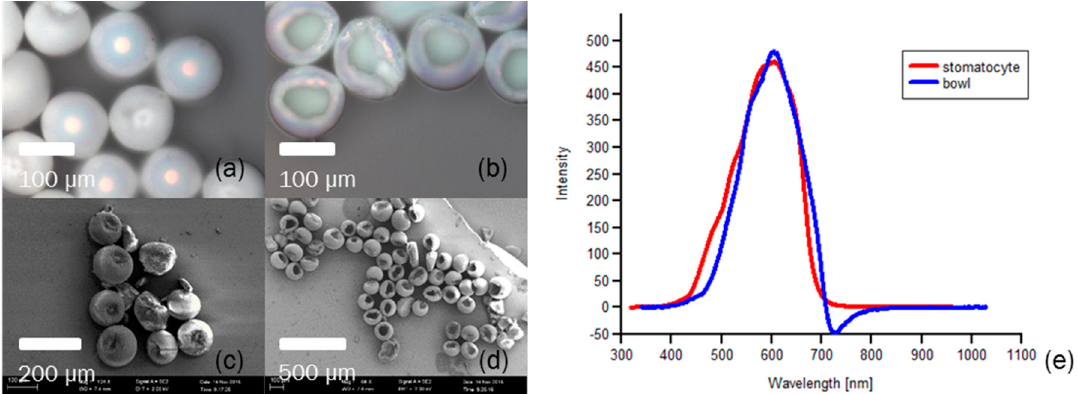
Figure 6. Optical images ( a , b ), SEM images ( c , d ) and reflectance spectrum ( e ) of polystyrene photonic crystal particles with different shapes.